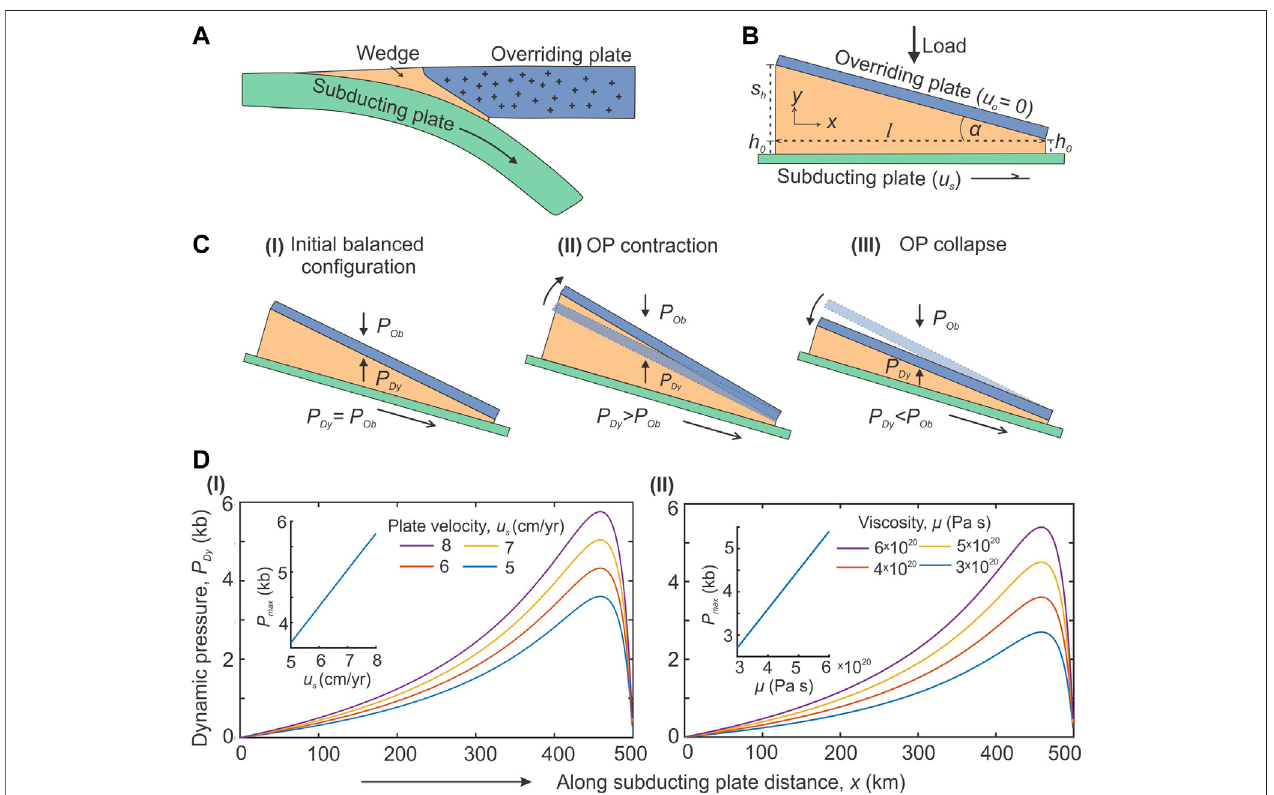
FIGURE 2 | (A) Schematic presentation of an orogenic wedge, forming the interface between the subducting and overriding plates in a subduction system. (B) Geometrical parameters of an orogenic wedge considered for the analysis of dynamic pressure within the wedge, where h 0 and ( h 0 + S h ) are the opening widths at the twoconvergingendsofthewedge, l isthealong-platelengthofthewedge,and α isconvergenceangle.Theoverridingplateiskeptstationary( u o (cid:1) 0)andthesubducting plate moves at velocity u s (cm/yr). (C) Three dynamic states of a subduction system. I: Wedge dynamic pressure ( P Dy ) equals to overburden pressure ( P Ob ), acting onthewedge-overridingplateinterface;thesystemisinabalancedstate.II: P Dy > P Ob ;theoverridingplate(OP)undergoescontractionaldeformation.III. P Dy < P Ob ;theOP undergoes rotational collapse. (D) Graphical plots of P Dy as a function of I) subduction plate velocity, u s and II) wedge viscosity, µ .